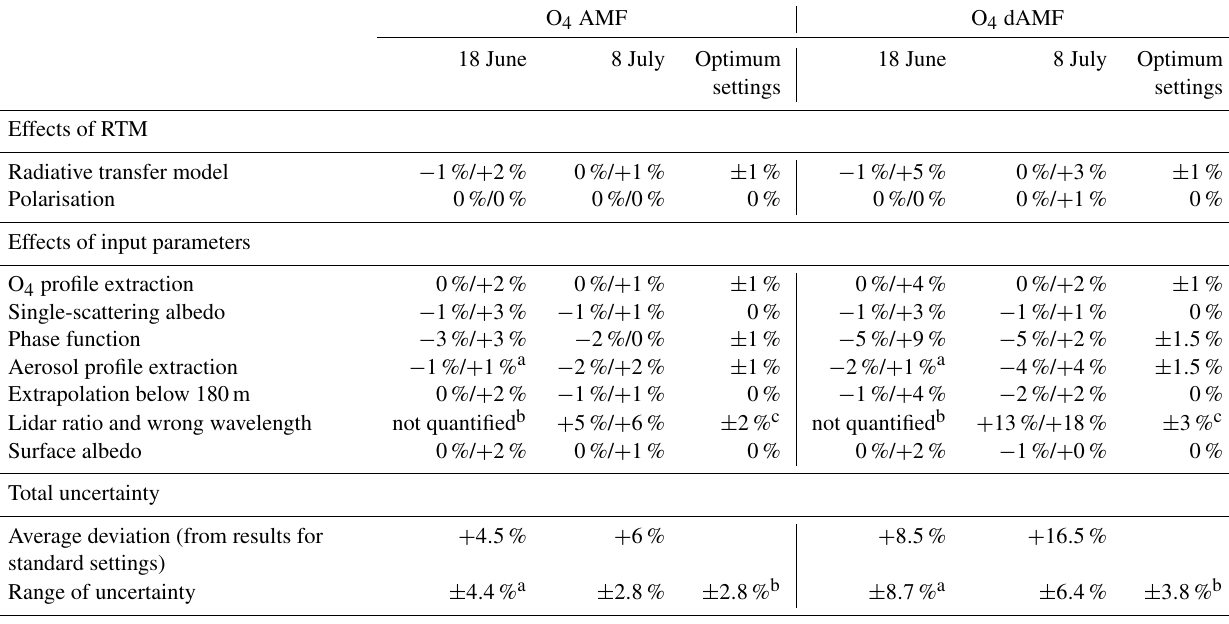
Table 9. Summary of uncertainties of the simulated O 4 (d)AMFs for the middle period of each selected day. The two numbers left and right of the slash indicate the minimum and maximum deviations. The columns with label “optimum” indicate the uncertainties which could be reached if the optimum information on the measurement conditions was available (e.g. height profiles of temperature, pressure and aerosol extinction as well as aerosol microphysical or optical